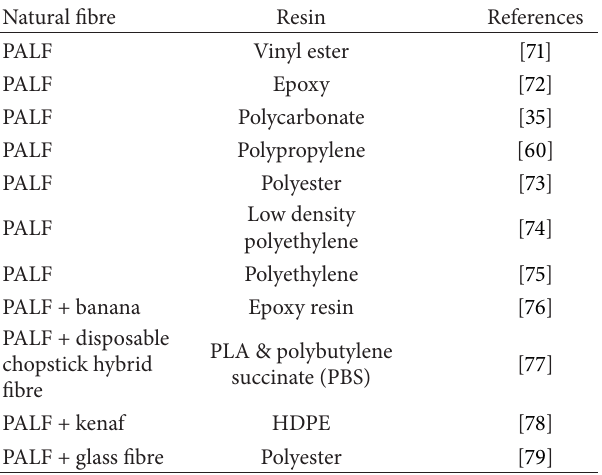
Table 9: PALF biocomposites and hybrid composites with ther- mosets and